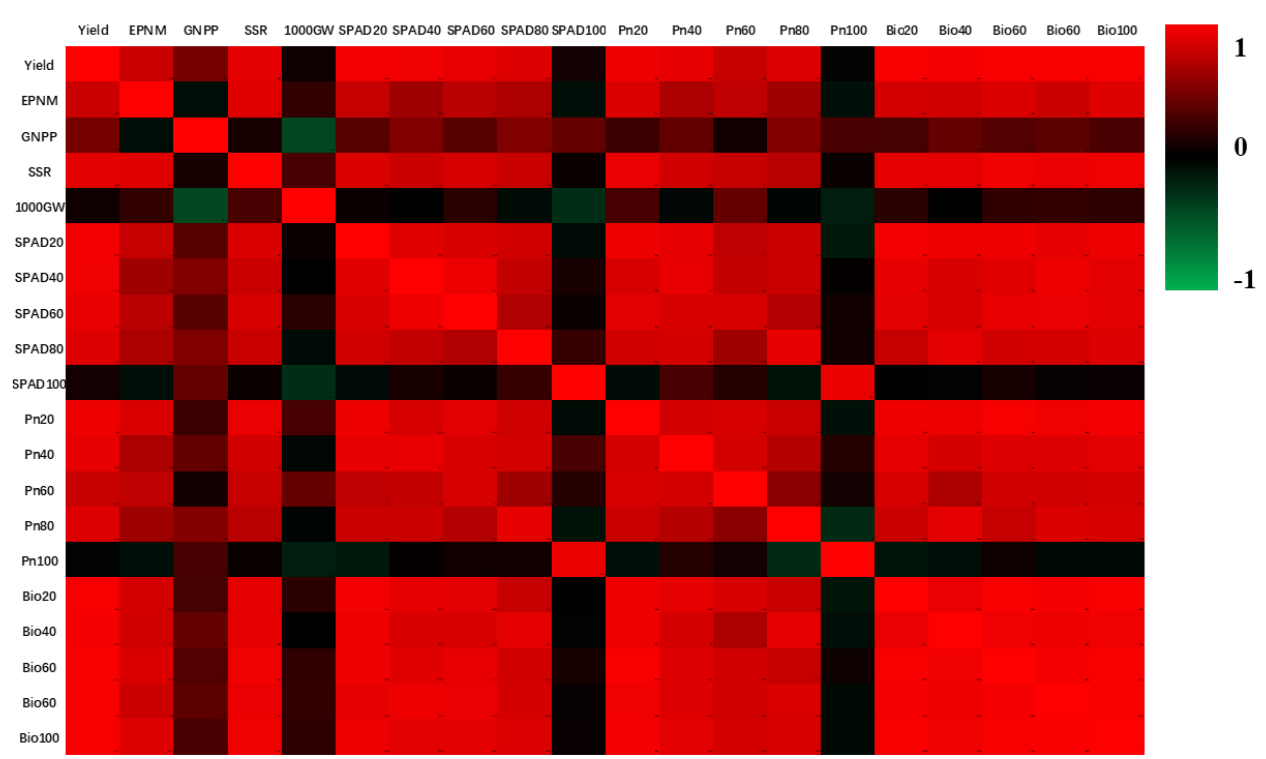
Figure 7. The heat map for grain yield, yield-related traits, SPAD value, and net photosynthetic rate. EPNM: Effectively